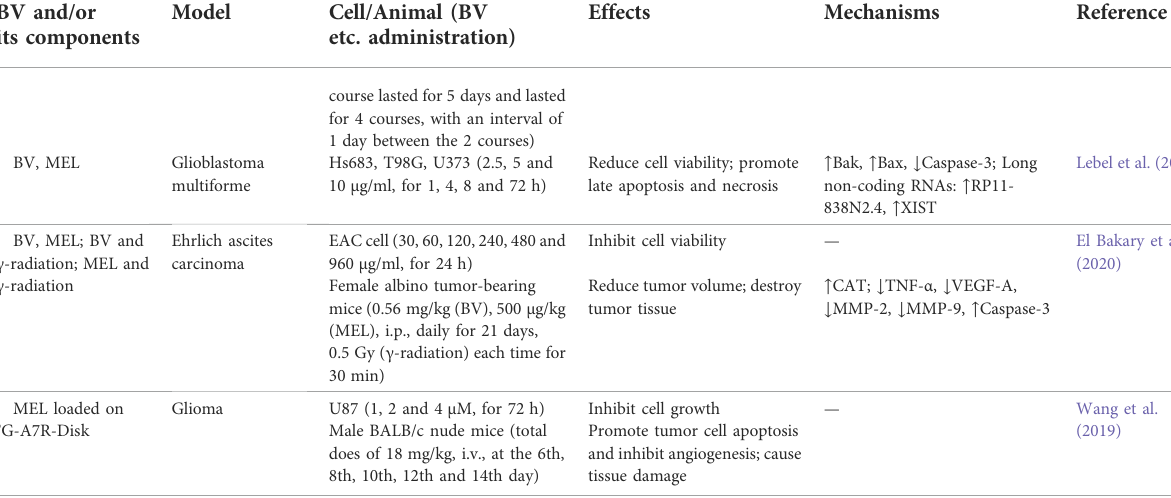
TABLE 1 ( Continued ) Summary of the anti-cancer effects and mechanisms of BV and its main components.